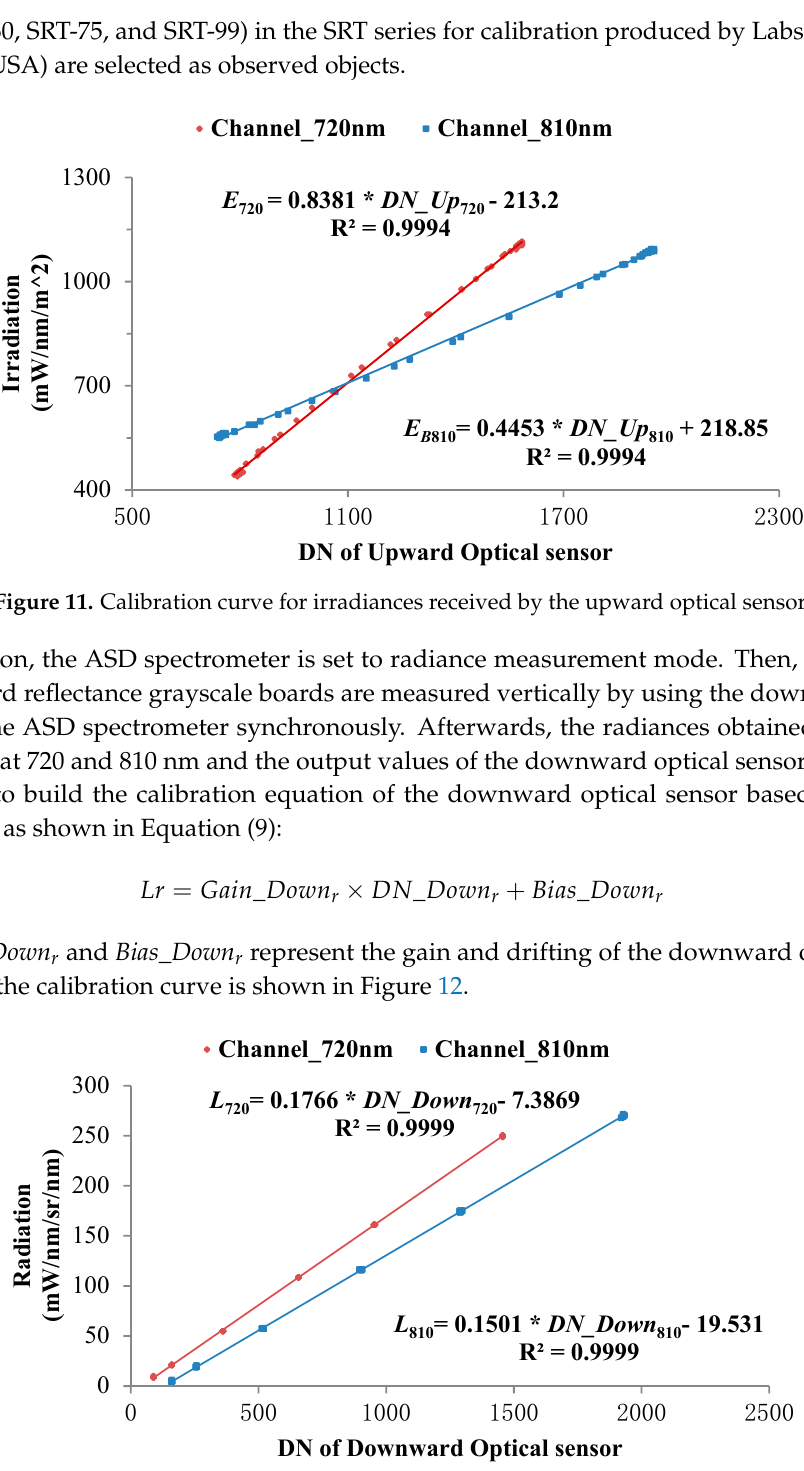
Figure 12. Calibration curve for radiances received by the downward optical sensor.